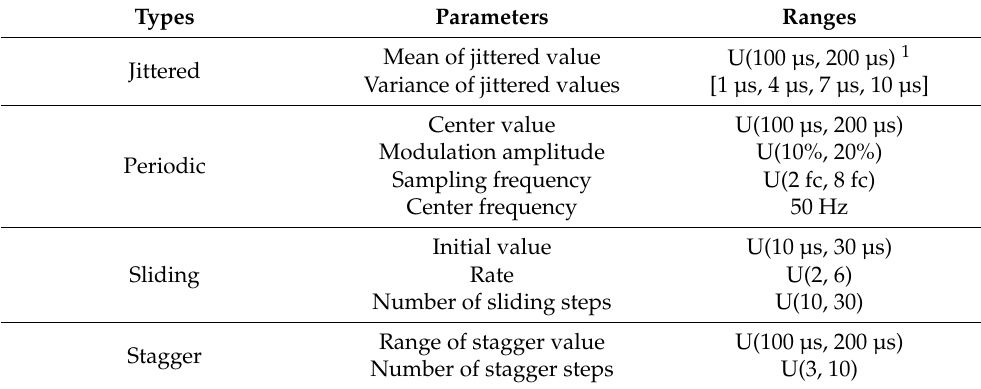
Table 1. Value ranges of modulation types and parameters.